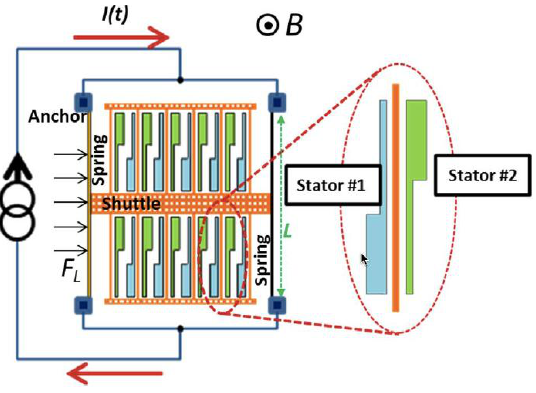
Figure 11. Schematic view of a MEMS magnetic field sensor formed with parallel plates, fixed stators, and a shuttle supported by two thin beams. This sensor uses the Lorentz force, which causes a displacement of its resonant structure measured through differential capacitors [28]. Reprinted with permission from [28]. Copyright© 2013, IEEE.